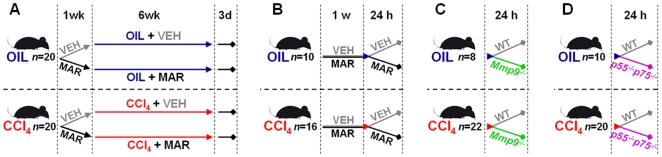
Design of the studies.Two groups of C57Bl/6J mice were randomized to two subgroups to receive either Marimastat or methylcellulose vehicle twice daily (A). Liver fibrosis was induced by repeated carbon tetrachloride (CCl4) administration for 6 weeks in one group of animals, whereas a second group of control animals received the mineral oil vehicle alone (A). The protective effects of Marimastat were further evaluated in a model of acute CCl4-induced hepatotoxicity (B). C57Bl/6J mice received either Marimastat or methylcellulose vehicle twice daily for 1 week, after which they were subjected to a single dose of CCl4 or mineral oil as control (B). The mechanism was further elucidated by subjecting Mmp9−/− mice and their wild type (WT) littermates (C), or TNF p55−/−p75−/− mice and their WT littermates (D) to either a single dose of CCl4, or mineral oil. In all acute CCl4-experiments, animals were sacrificed after 24 hours. Oil, non-fibrotic control group; CCl4, fibrotic mice; VEH, vehicle treated control group; MAR, Marimastat treated experimental group; WT, wild type.